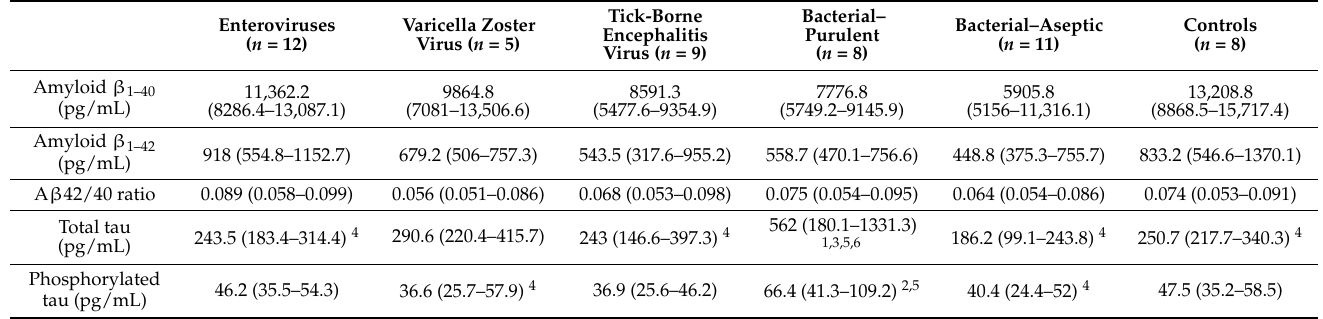
Table 2. Cerebrospinal fluid concentrations of biomarkers of Alzheimer’s disease in study groups.